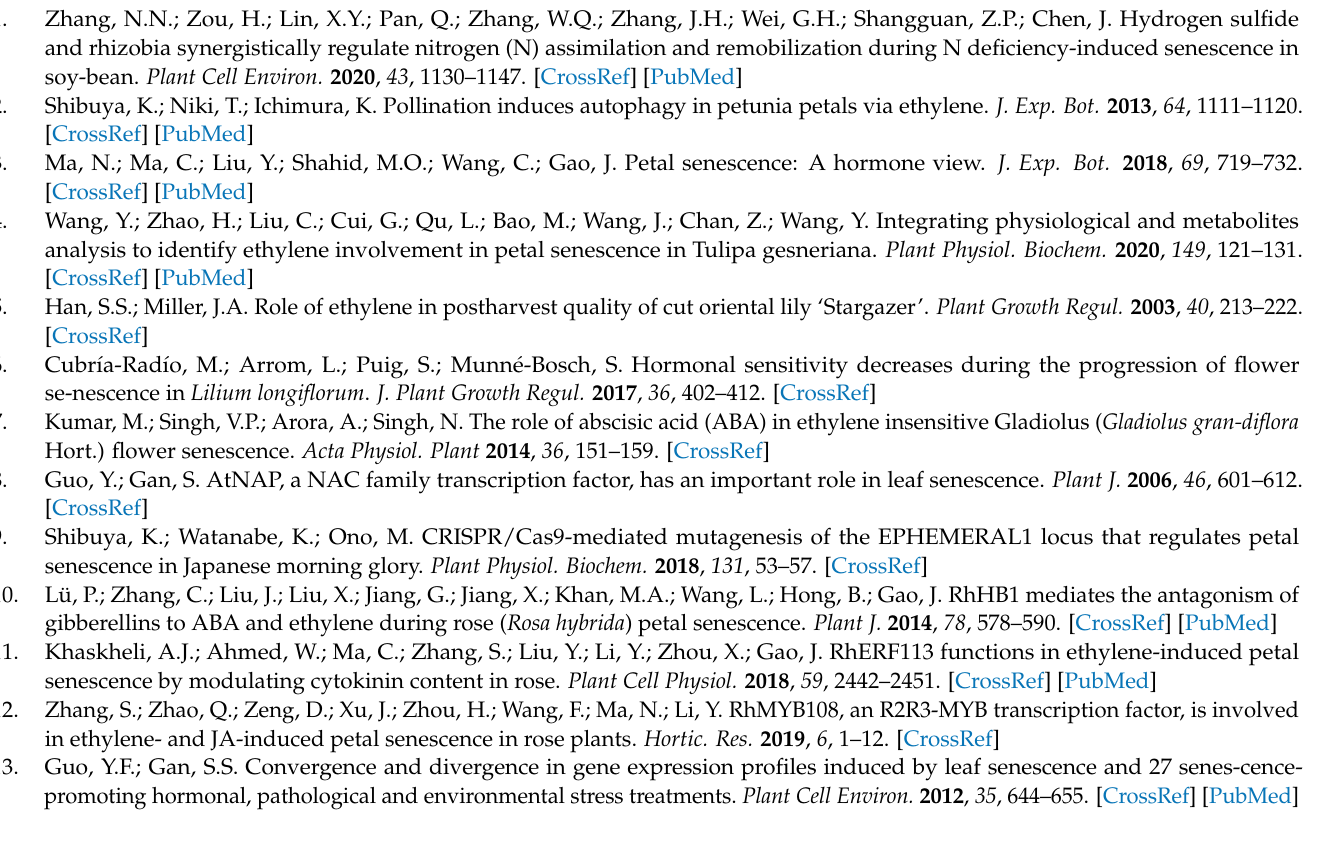
tree of LoNAC29 , Table S1: primers, Table S2: Statistics of original SMRT sequencing data, Table S3: Annotation of 73,218 non-redundant transcripts, Table S4: Gene lists in cogent analysis, Table S5: Analysis of differentially expressed genes, Table S6: Analysis of transcription factors, Table S7: Homolog genes in lily ( Lilium oriental ‘Siberia’) of published senescence-associated transcrip- tion factors, Table S8: Upregulated DEG_KEGG_pathway_enrichment in S1 vs S2 & S1 vs S3 & S1 vs S4, Table S9: Chlorophyll metabolism- and photosynthesis-related genes, Table S10: Transcrip- tion factors co-expressed with chlorophyll-metabolism-related genes, Table S11: Downregulated DEG_KEGG_pathway_enrichment in S1 vs S2 & S1 vs S3, Table S12: Terpenoid-biosynthesis-related genes, Table S13: Transcription factors co-expressed with terpenoid-biosynthesis-related genes, Table S14: Senescence associated genes, Table S15: Comparison of published lily transcriptome with SMRT and Illumina RNA Sequencing in this